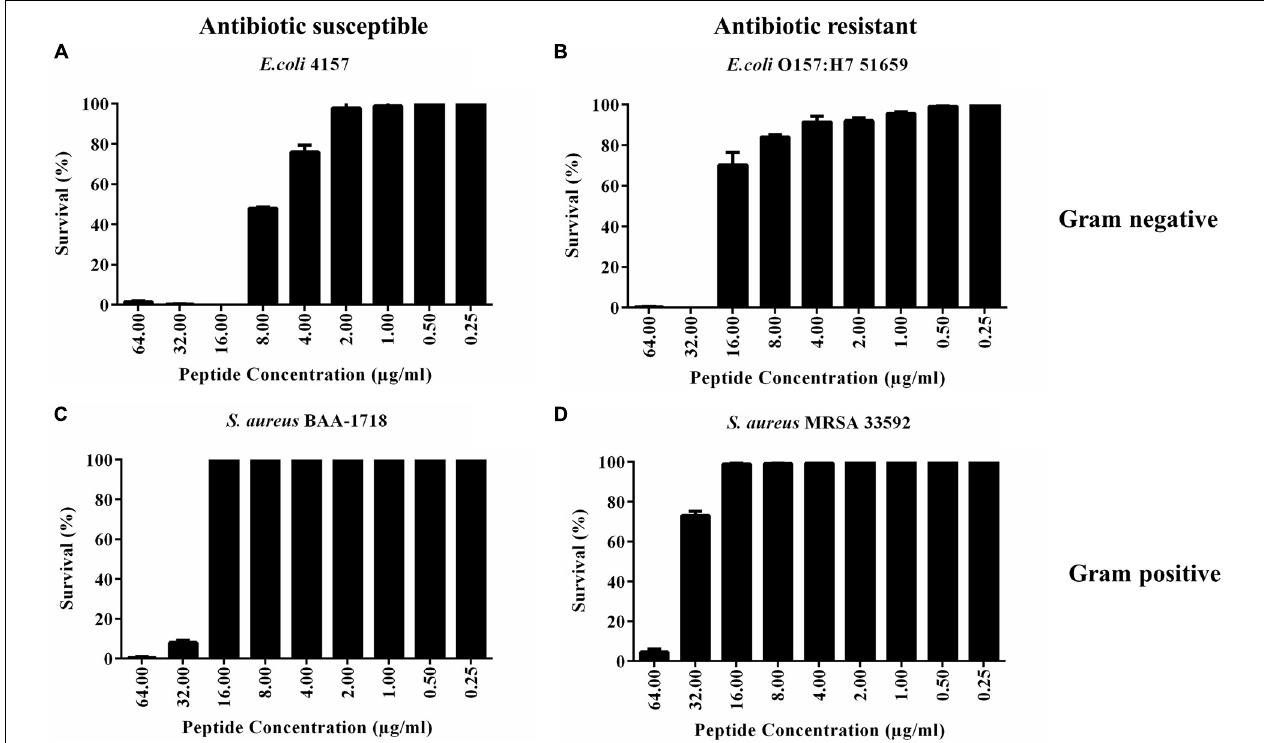
FIGURE 4 | Minimum inhibitory concentration (MIC) of PHNX-1 against four strains of bacteria. (A) Antibiotic susceptible E. coli 4157 (MIC = 16 µ g/ml). (B) E. coli O157:H7 51659 (MIC = 32 µ g/ml). (C) S. aureus BAA-1718 (MIC = 32 µ g/ml). (D) S. aureus 33592 (MIC = 64 µ g/ml).